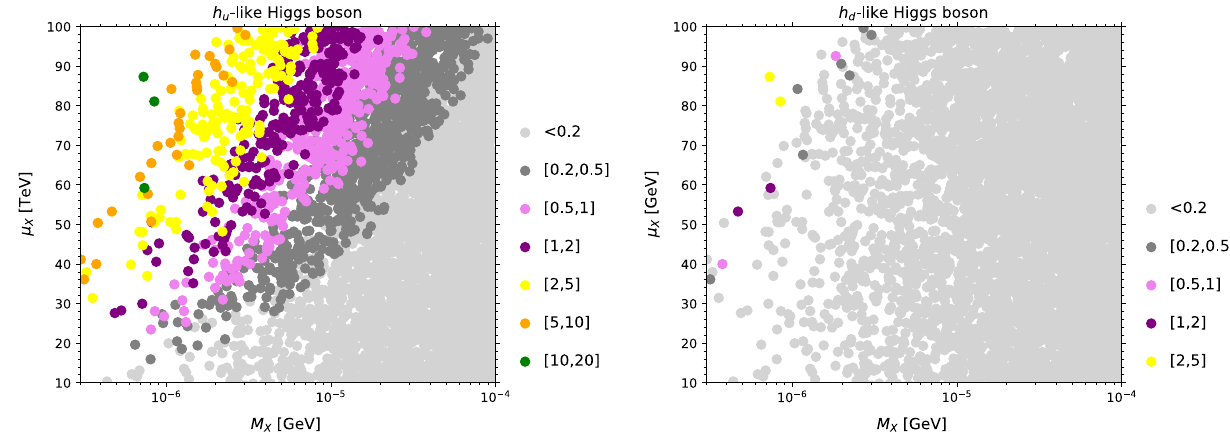
Fig. 6 Scatter plots in the plain of two variables of the neutrino sector, ( M X ,μ X ) for the h u -like (left) and the h d -like (right) Higgs boson. The color code indicates the relative correction (cid:11) (defined in (5.106)) for each Higgs state in